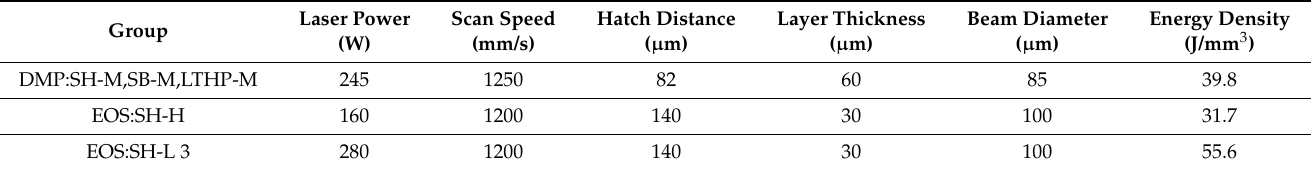
Table 1. Ti-6Al-4V infill build parameters fabricated on the M290 and DMP320 LPBF systems. Note: Group SH-L was fabricated with reduced power to intentionally produce components with higher defect